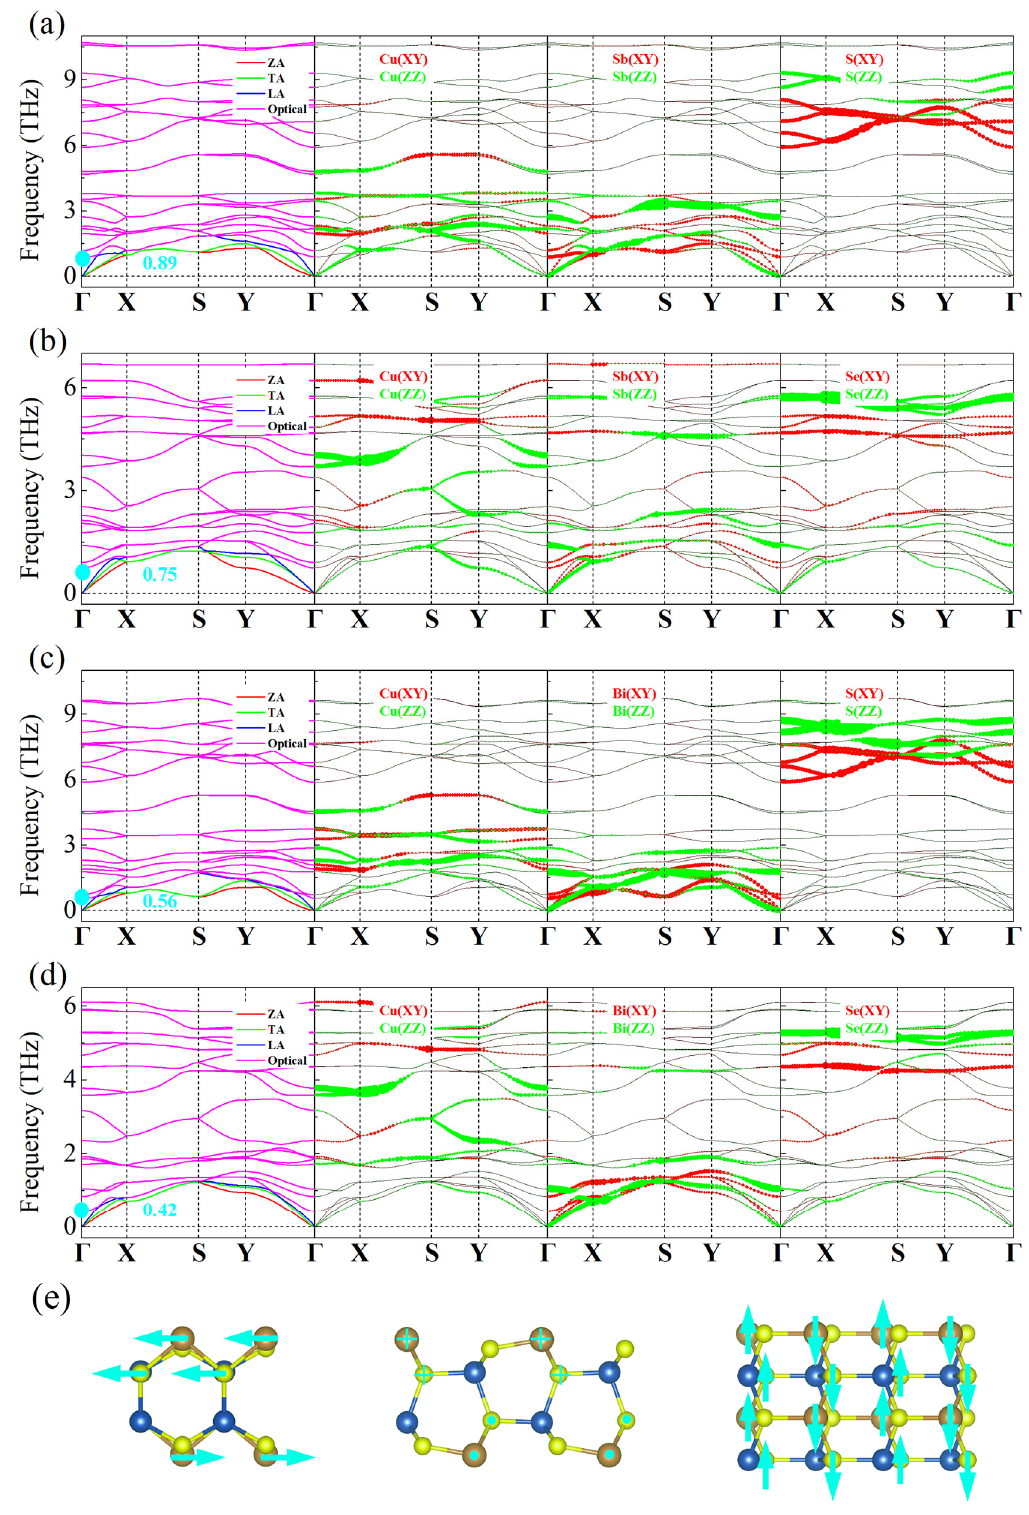
Figure 5. The orbital-resolved phonon dispersion of: ( a ) CuSbS 2 ; ( b ) CuSbSe 2 ; ( c ) CuBiS 2 ; ( d ) CuBiSe 2 ; where the XY and ZZ denote the in-plane and out-of-plane phonons; and ( e ) the schematic diagram of low frequency optical phonon at Γ point for monolayer CuSbS 2 , where the arrows represent the direction of the vibration.